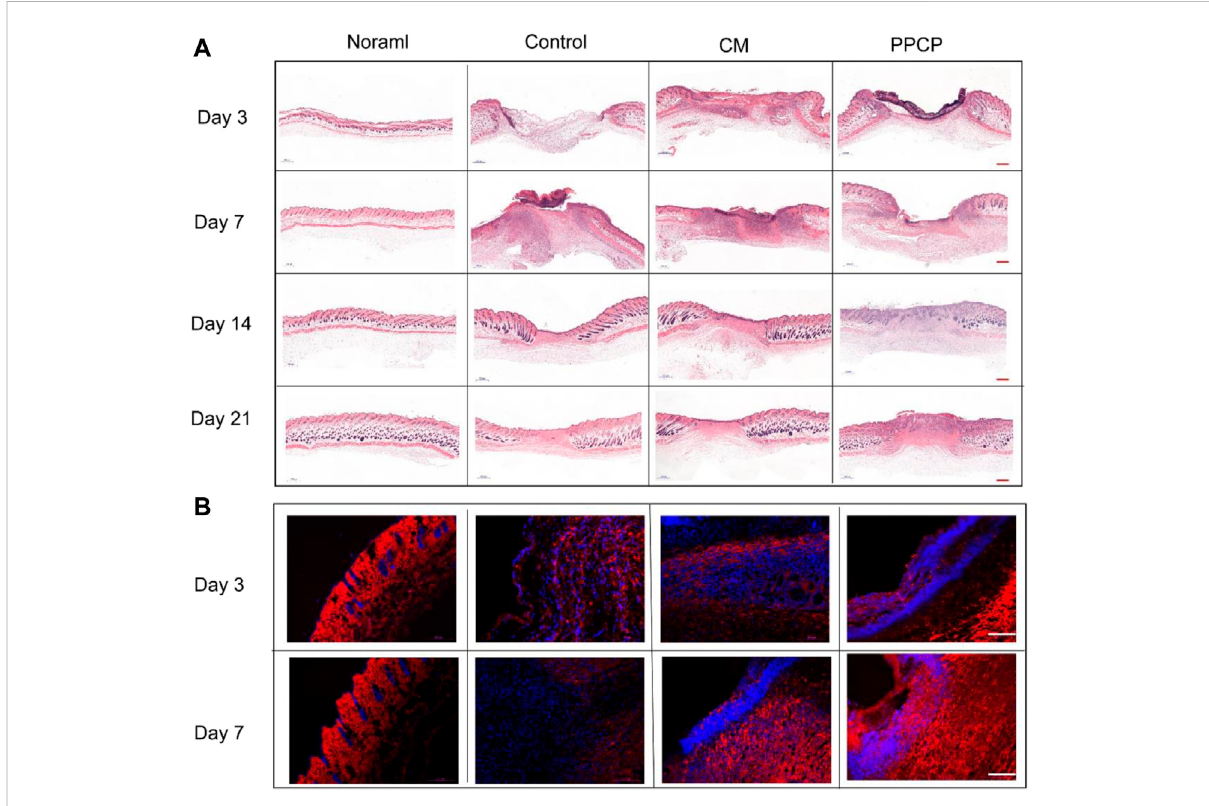
FIGURE 6 Picture of tissue stained with H&E and immuno fl uorescence. (A) H&E stained pictures of peri-wound skin tissue on days 3, 7, 14, and 21 after treatment (scale bar represents 500 μ m). (B) Representative immuno fl uorescence images of wound sections stained with collagen I of different treatment groups on days 3 and 7. (scale bar represents 100 μ m; blue represents nucleus and red depicts antibody